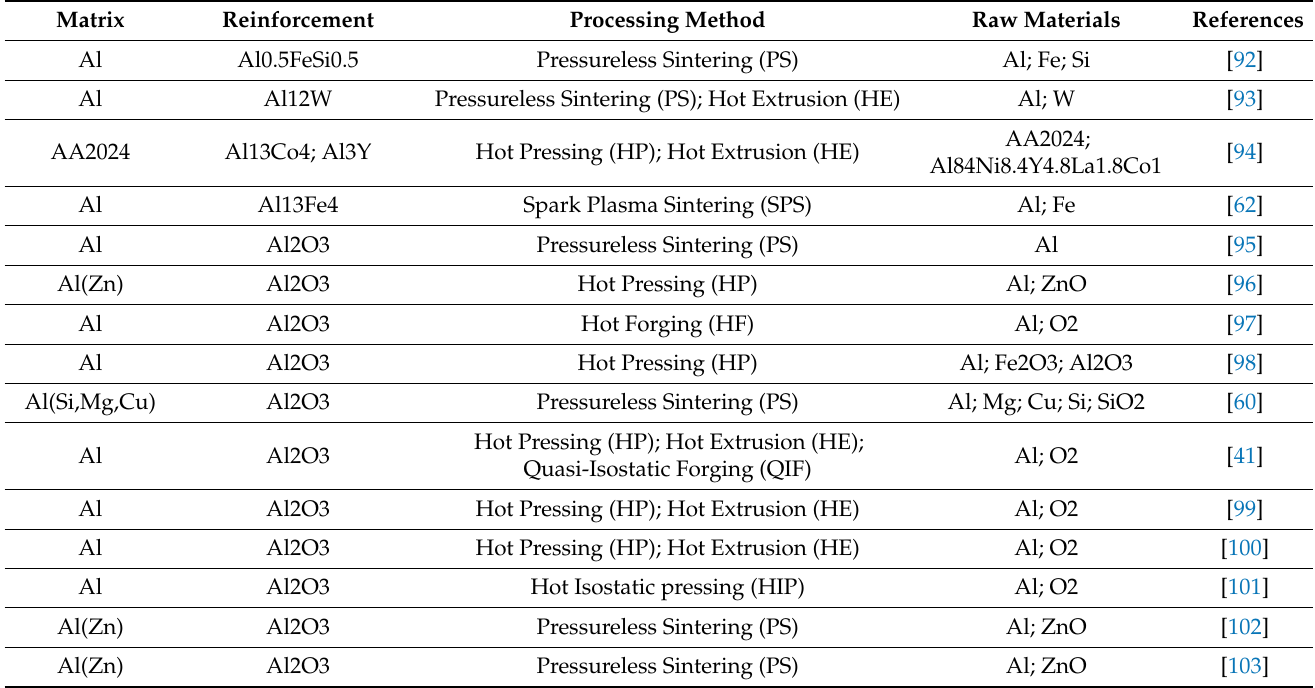
Table A2. Aluminum Matrix